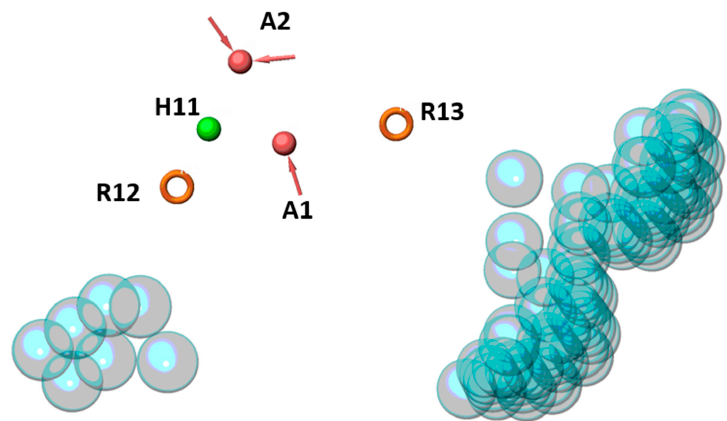
Figure 2. Pharmacophore hypothesis AAHRR. Orange circles, pink and green spheres indicate aromatic rings, hydrogen bonds acceptors and hydrophobic region features, respectively. Excluded volumes are depicted as translucent cyan spheres.